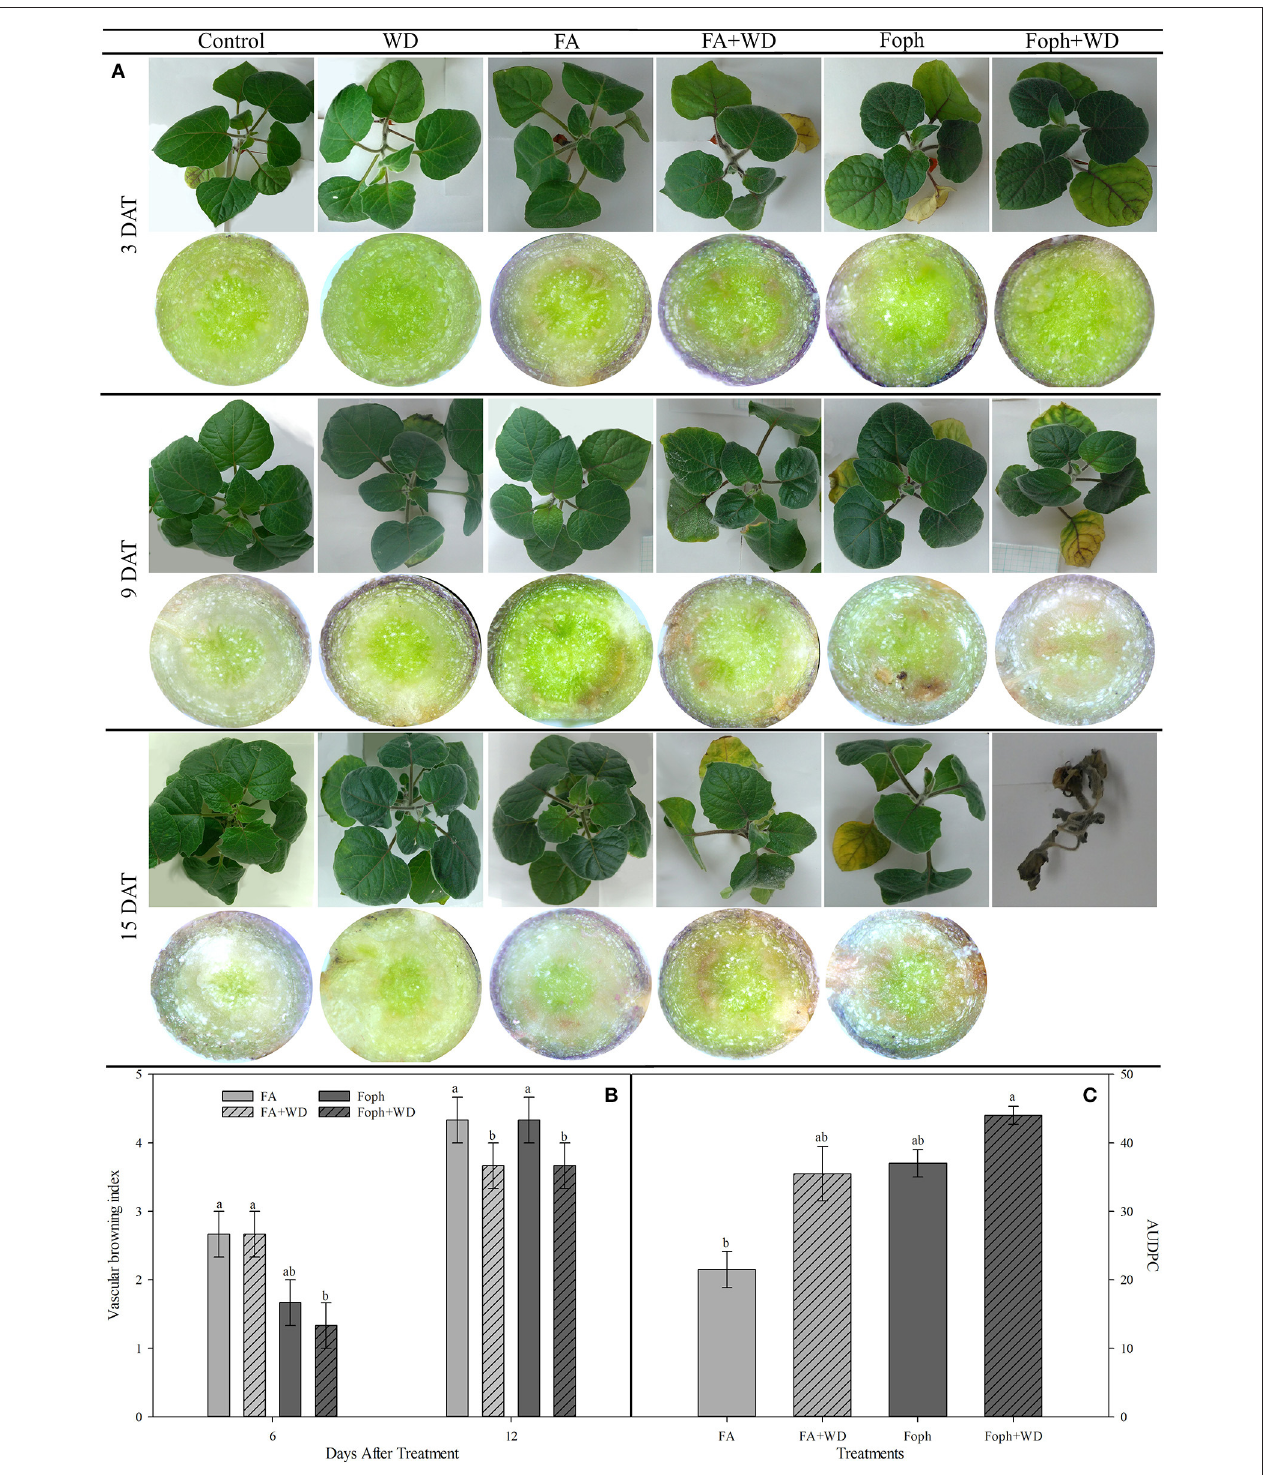
FIGURE 4 | Effect of fusaric acid (FA), F. oxysporum f. sp. physali (Foph) and water deficit (WD) on cape gooseberry ecotype Colombia in a hydroponic system for 15 days. (A) Plant symptoms and their vascular bundles, (B) vascular browning index, and (C) area under disease progress curve (AUDPC). In (B) and (C) , neither vascular browning nor disease symptoms were observed in control plants; therefore, their values for each evaluated variable were 0. DAT, days after treatment. Chart bars represent the mean of four values ± standard error ( n = 3). Bars followed by different letters indicate statistically significant differences according to the Tukey test ( P ≤